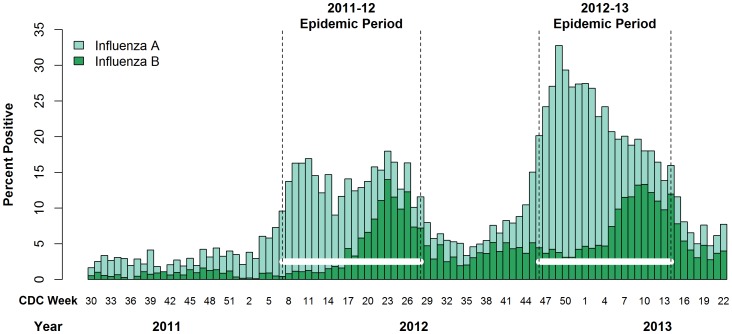
Establishing Influenza Epidemic Periods.The proportion of the laboratory specimens positive for influenza A (light bar) and B (dark bar) viruses among isolates submitted by the states of the Health and Human Services Southeastern Health Region 4 to the National Respiratory and Enteric Virus Surveillance System maintained by the United States Centers for Disease Control and Prevention (CDC). Data are shown for 2011/12 and 2012/13. [24] Influenza epidemic periods (horizontal bars) for each year are defined using CDC criteria [22], [23].